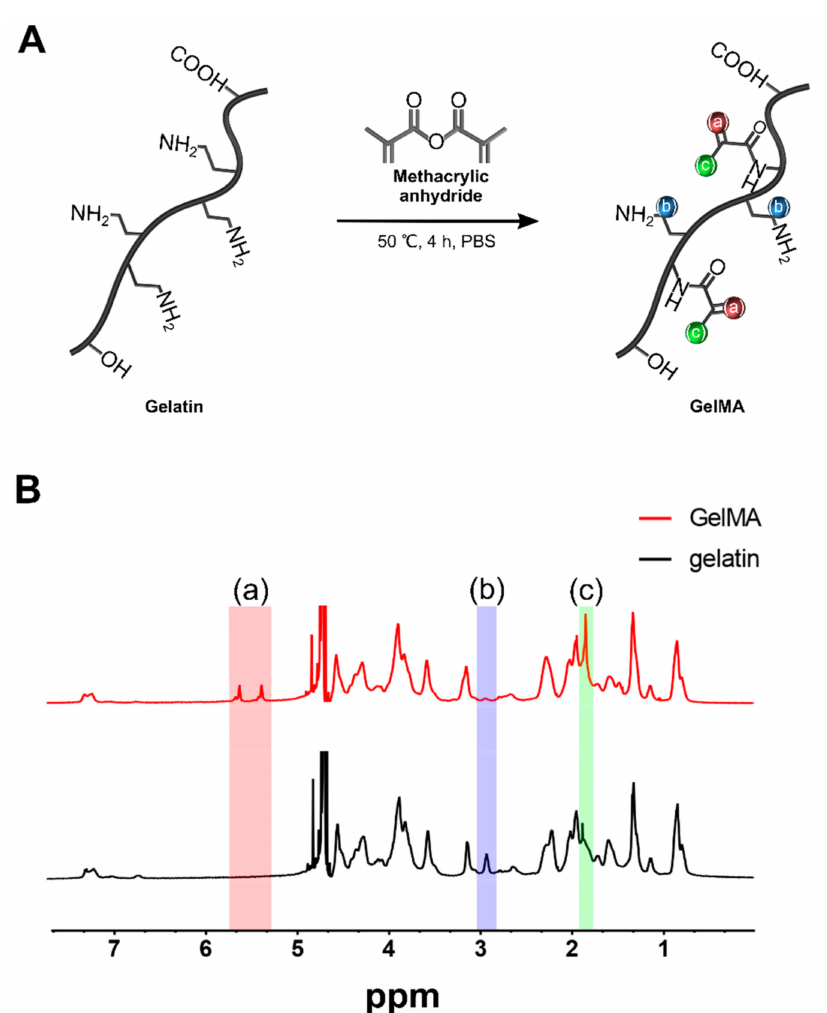
Figure 1. ( A ) GelMA was synthesized by reacting gelatin with methacrylic anhydride (MA) to introduce a methacryloyl substituent to the reactive group of the lysine residue. The methylene group of lysine in GelMA is indicated by blue (b), and the new functional groups are indicated by red (a) and green (c). ( B ) 1 H NMR of gelatin and